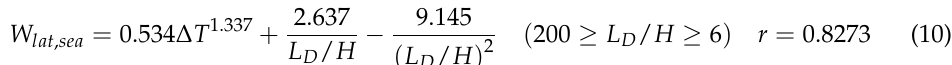
Figure 9. The statistical relationship between the lateral melting rate and the temperature difference, and the ratio of the diameter and the sample thickness. ( a ) Sea ice ( b ) fresh-water ice. According to the fitted results in Figure 9a, the parametrization scheme for the lateral melting of sea ice can be expressed